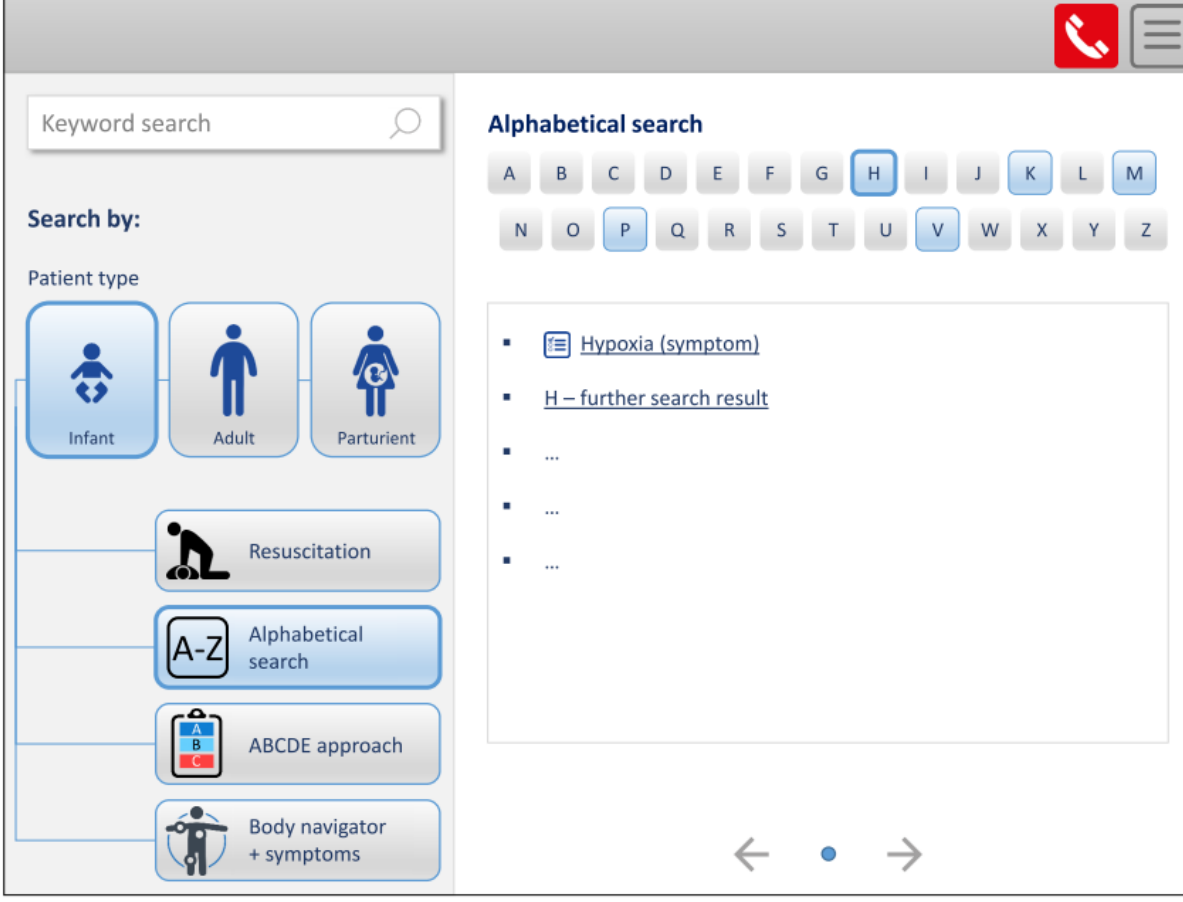
Figure 4. Third prototype, patient type infant selected, alphabetical search (adapted from the German